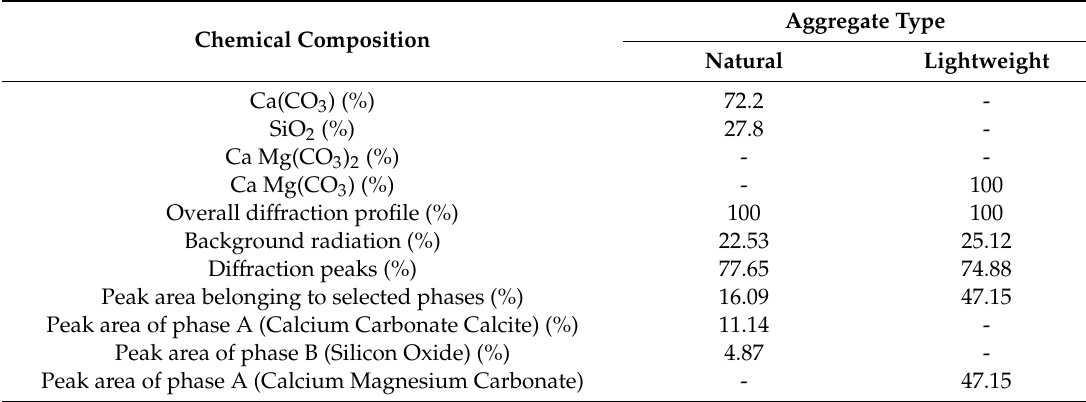
Table 4. Chemical properties of natural and lightweight aggregates.